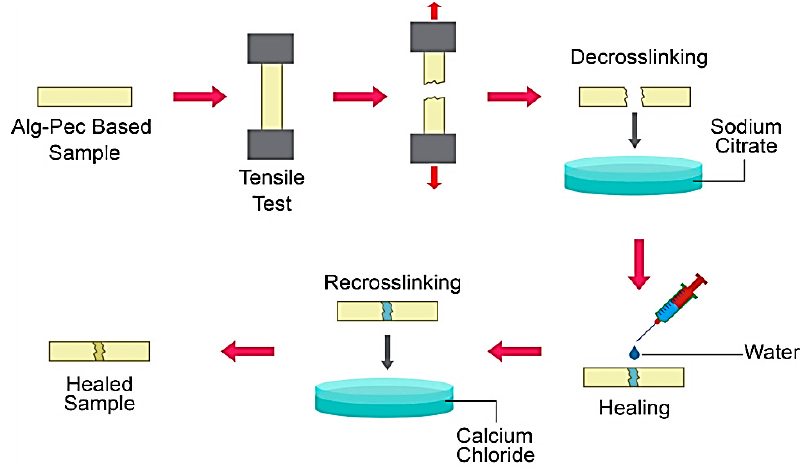
Figure 2 . Healing process of alginate–pectin (Alg–Pec) based samples. Figure 2. Healing process of alginate–pectin (Alg–Pec) based